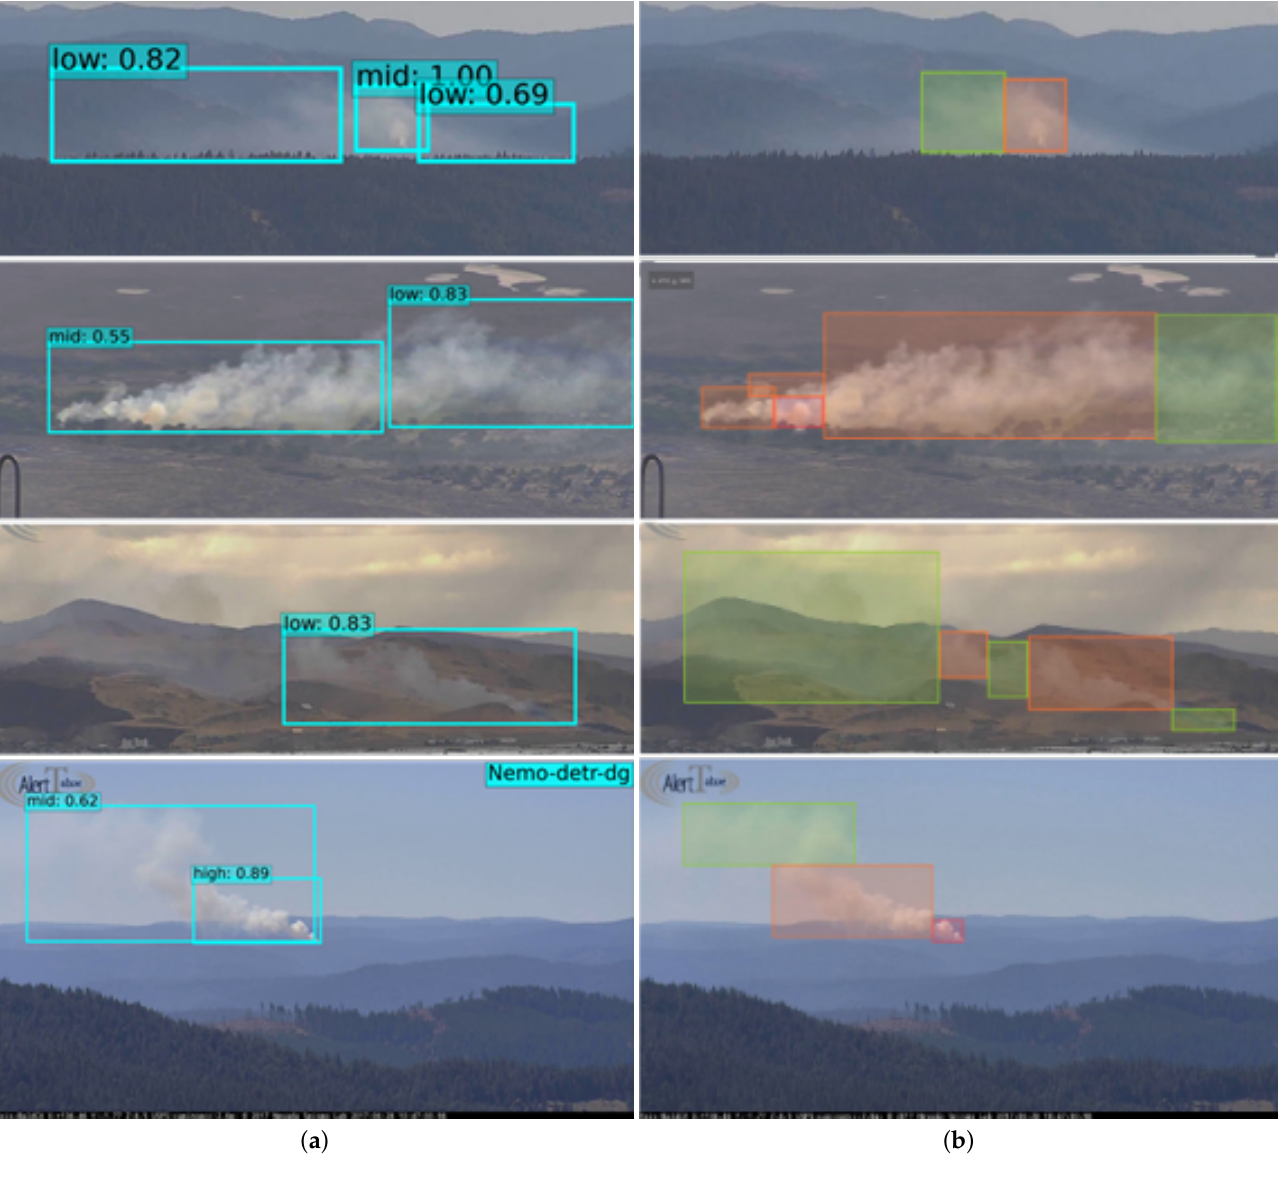
Figure A2. Examples of smoke density predictions vs. the ground truth that contributed to the low average precision (AP) of our density detectors. The first three rows are zoomed in for better illustration. ( a ) shows the predicted bounding boxes based on Nemo-DETR-dg. ( b ) Ground truth. The bounding box drawing and labeling inconsistencies significantly impact the calculated AP. The predictions on the left correctly identify the smoke region with a density that is at most one level off the ground truth. A more accurate and consistent labeling of the data could improve the calculated